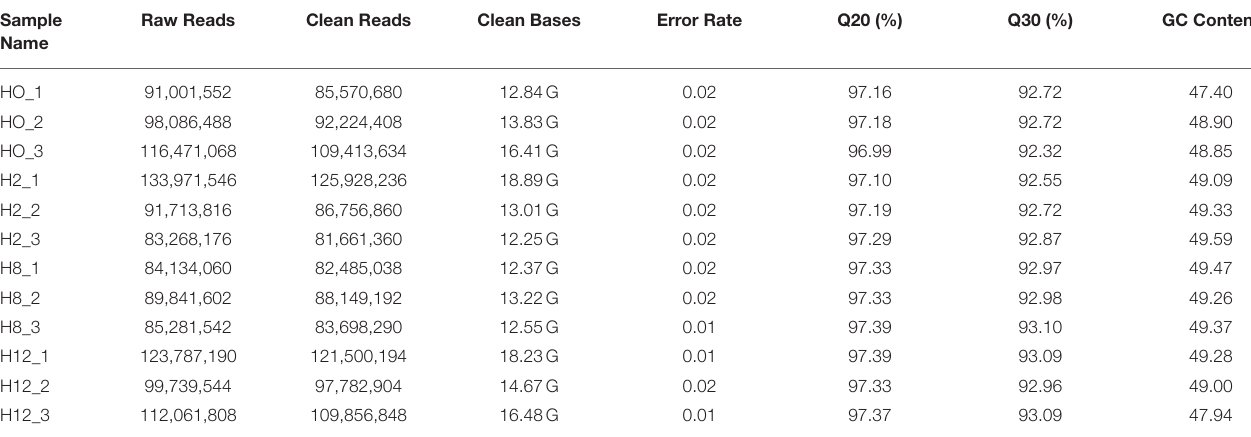
TABLE 1 | Information of lncRNAs sequencing